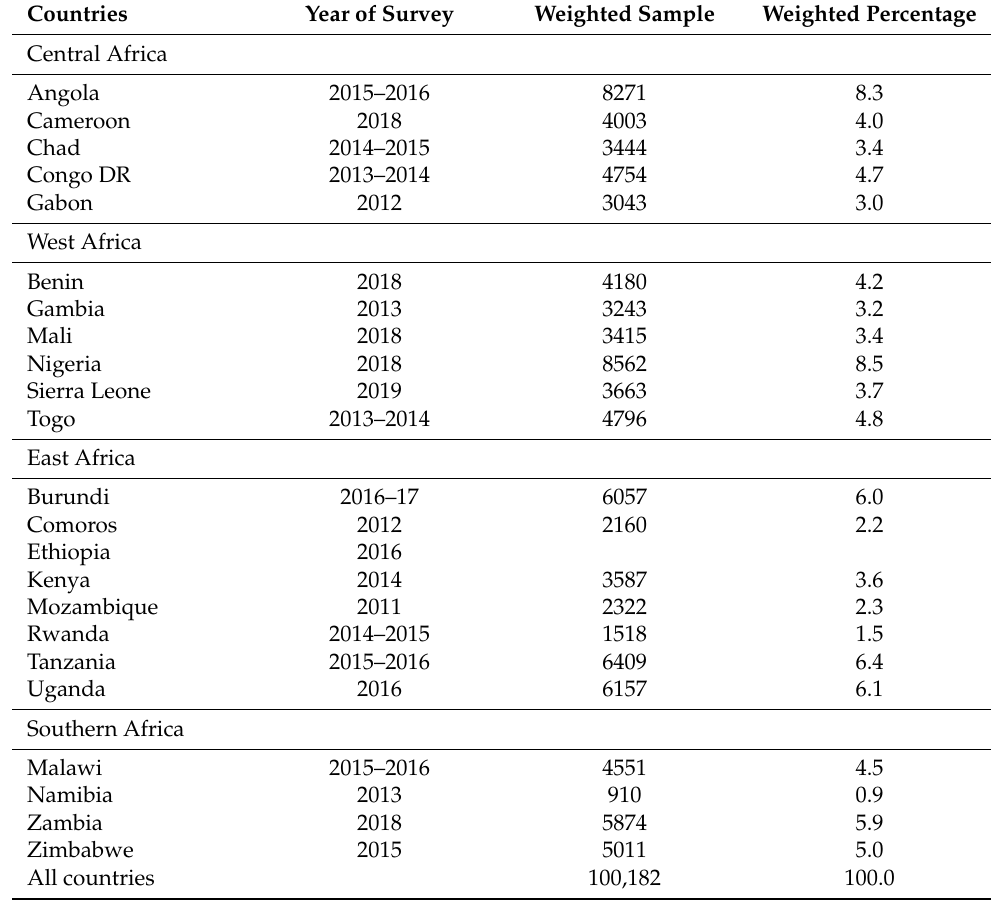
Table 1. Description of